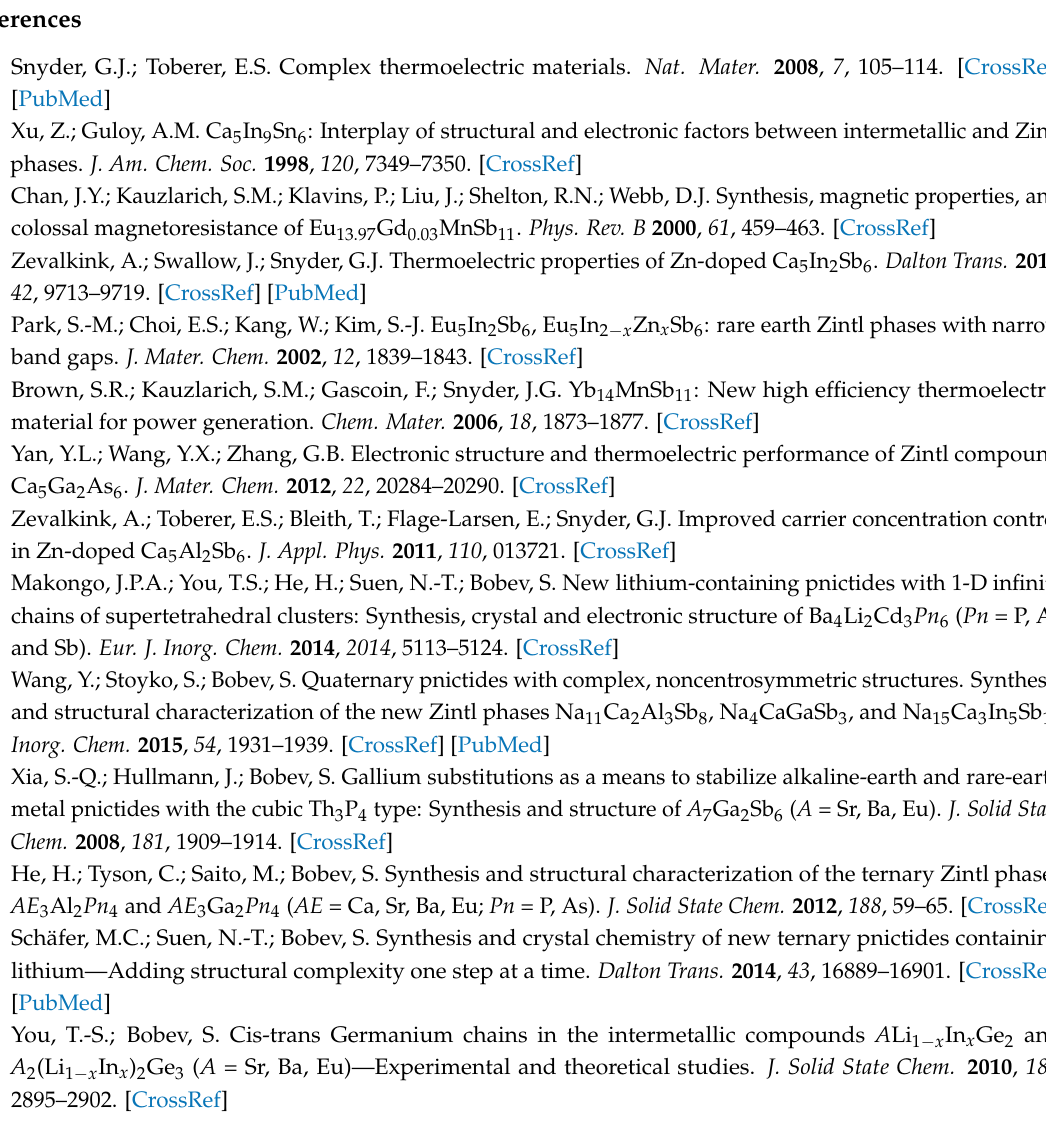
Figure S1: Polyhedral representation of the crystal structure of EuLi 2.58 In 0.42(2) Bi 2 , Table S1: Selected crystal structure data and refinement parameters for EuLi 2.58 In 0.42(2) Bi 2 , Table S2: Final refined positional coordinates and displacement parameters for EuLi 2.58 In 0.42(2) Bi 2 , A combined CIF and checkCIF for all discussed